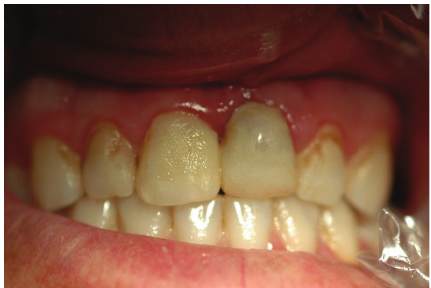
Figure 7: Photograph at fifth week after replantation; right and left maxillary incisors were restored.